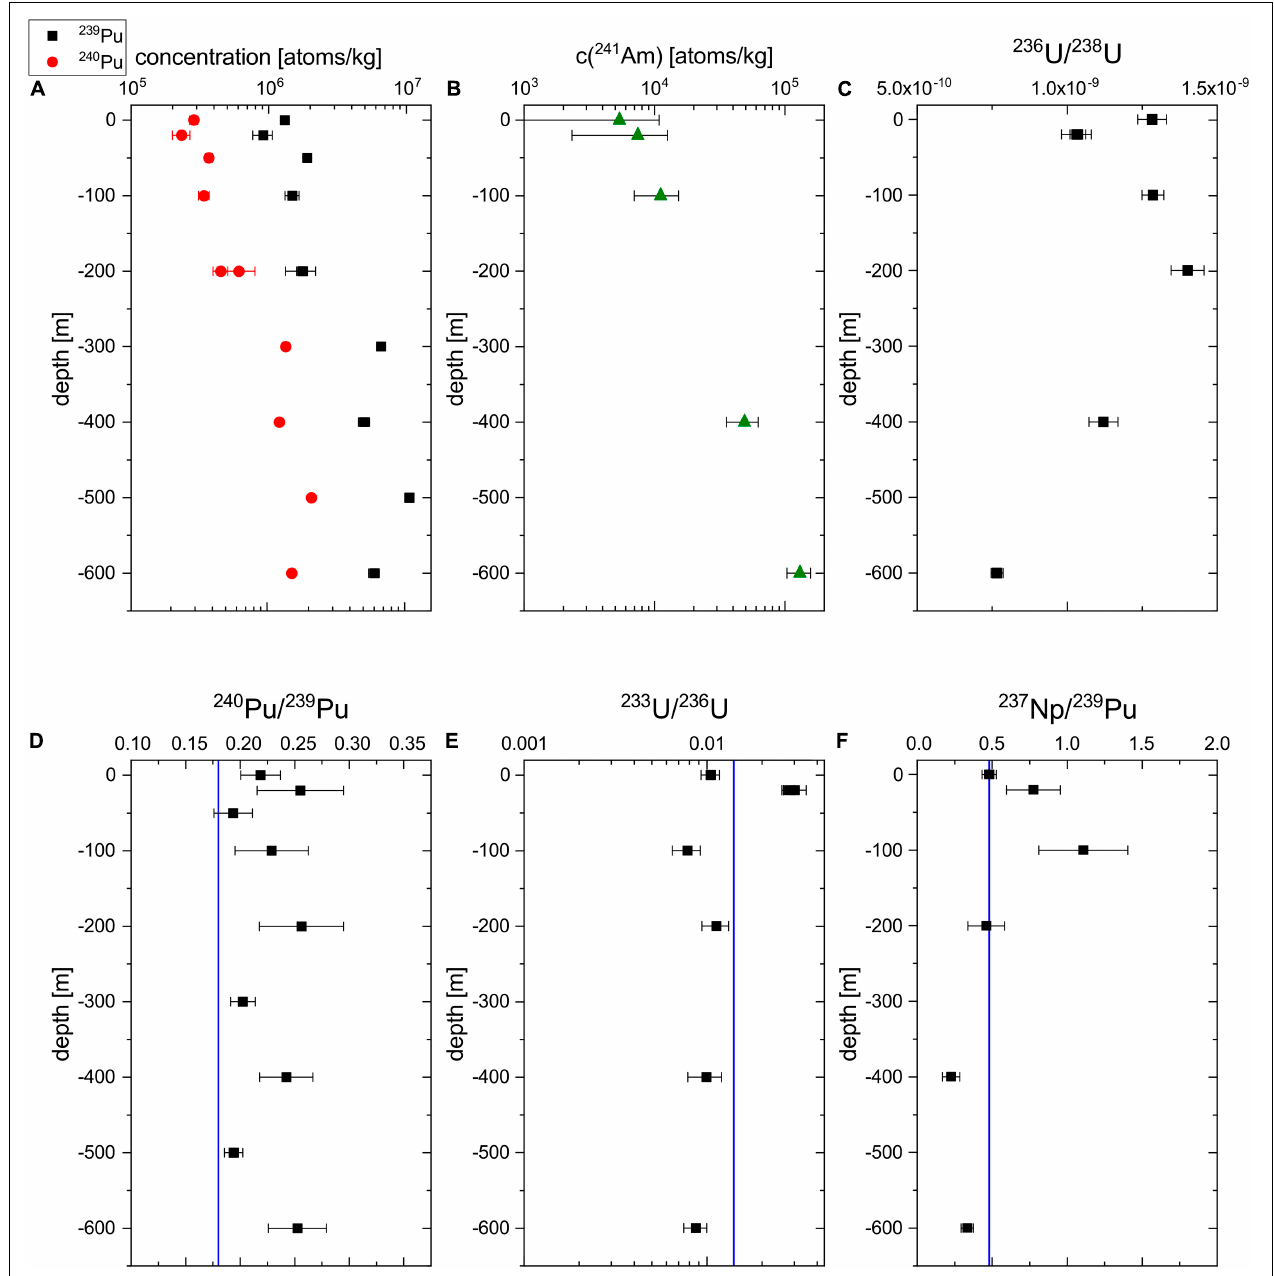
FIGURE 2 | Depth profiles of the 239 Pu (black) and 240 Pu (red) concentration (A) , the 241 Am (green) concentration (B) , the 236 U/ 238 U atom ratio (C) , the 240 Pu/ 239 Pu atom ratio (D) , the 233 U/ 236 U atom ratio (E) , and the 237 Np/ 239 Pu count rate ratio (F) at the sampling station BD04. The vertical blue line indicates the literature value for global fallout of the respective radionuclide ratio (Kelley et al., 1999; Hain et al., 2020). For the Pu depth profiles, the new data has been combined with the data from a previous study (Hain et al.,